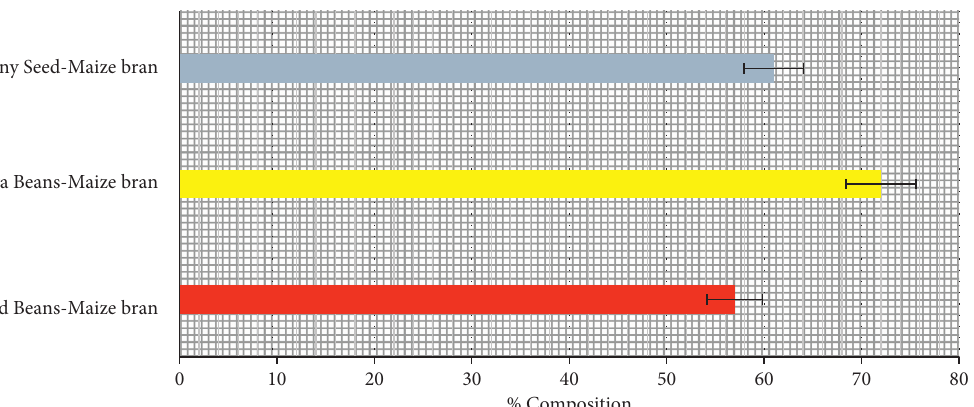
Figure 3: Percentage total carbohydrate content of